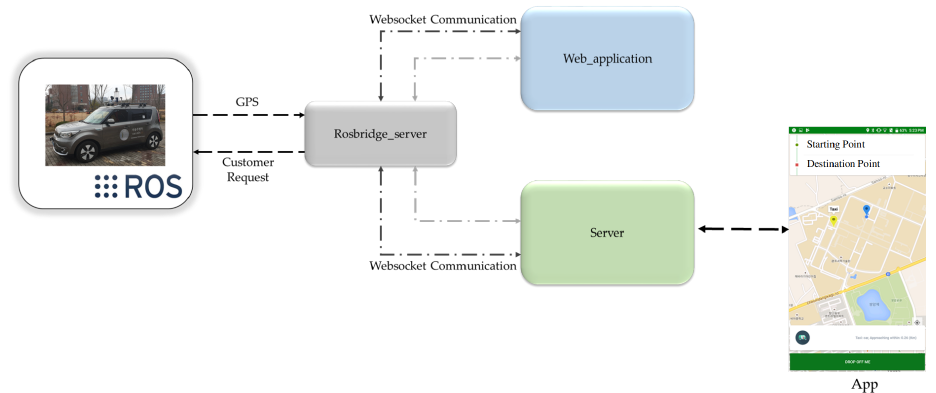
Figure 22. The framework of cab booking service (Best viewed in color).